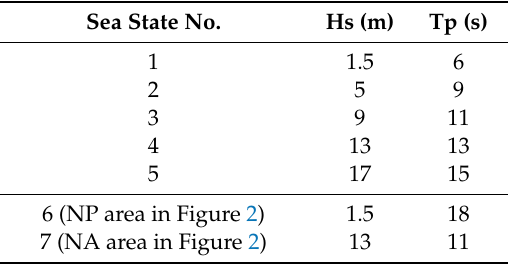
Table 2. Simulated sea states and their parameters.